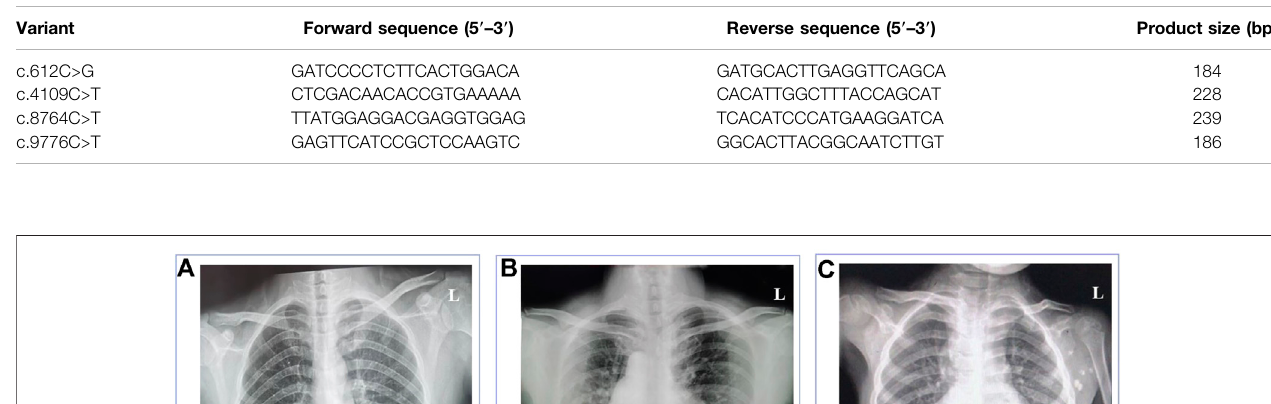
Frontiers in Genetics |